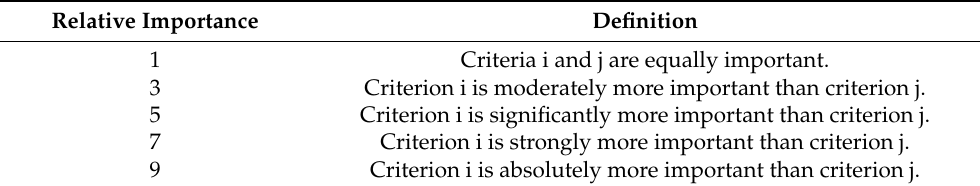
Table 2. Pairwise comparison scale in